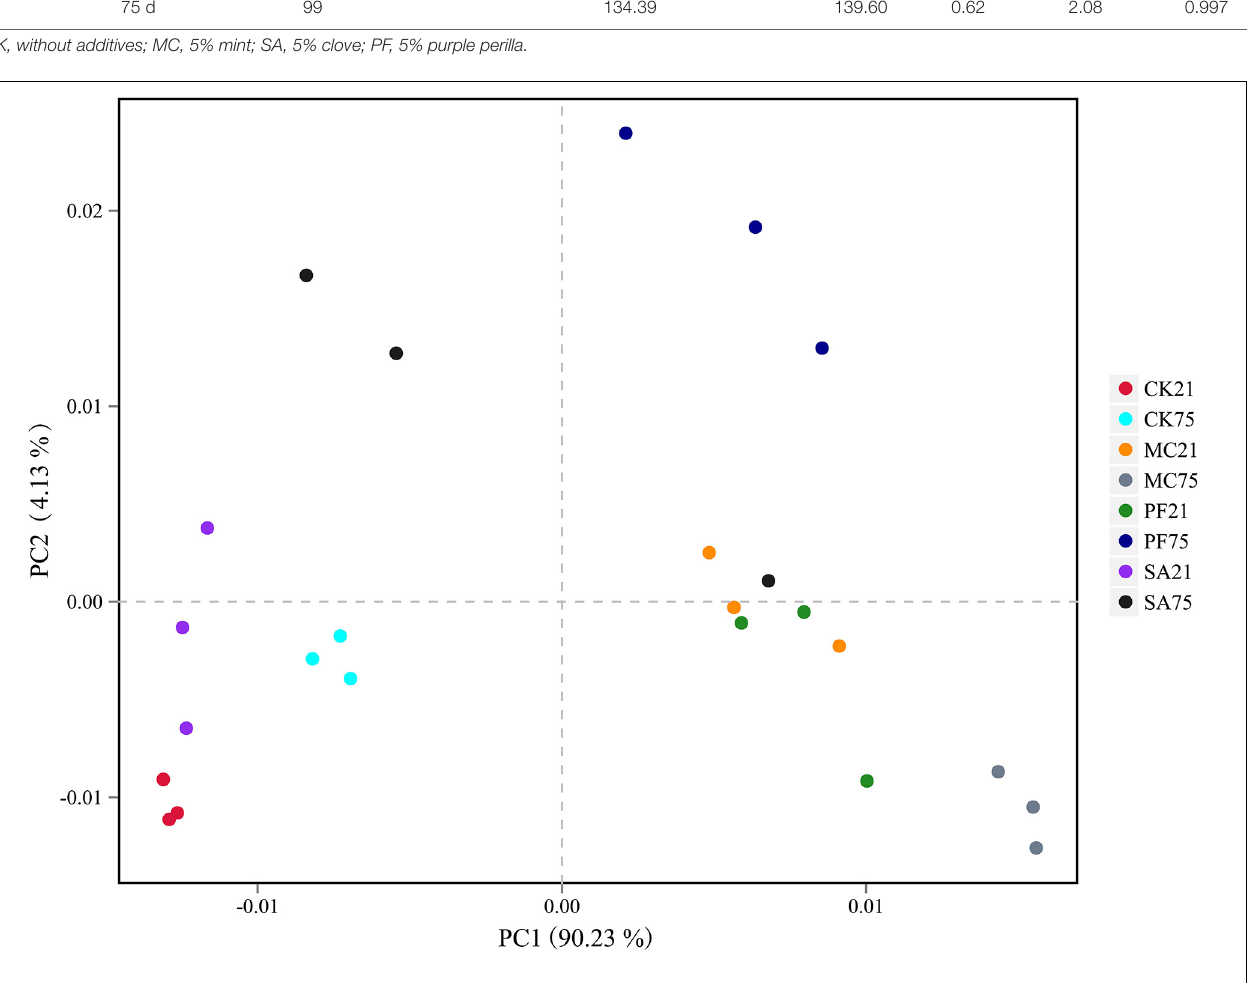
Frontiers in Microbiology |